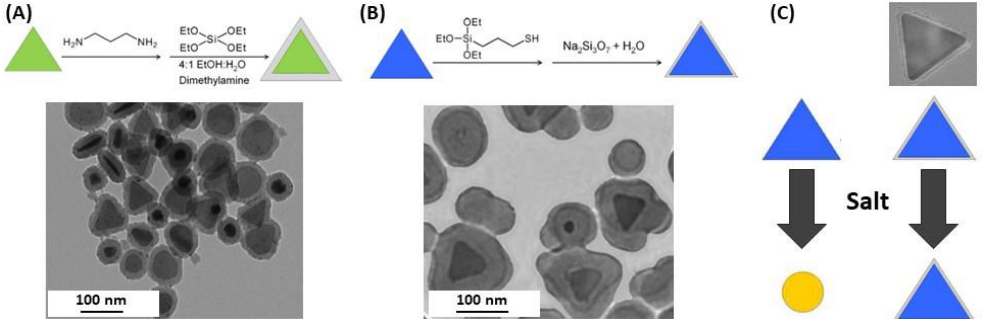
Figure 13. Silica coating of Ag triangular nanoplates by ( A ) diaminopropane priming and ( B ) (3-Mercaptopropyl)triethoxysilane (MPTES) priming followed by deposition from Na 2 Si 3 O 7 solution. ( C ) The silica shell using MPTES on triangular nanoplates (AgTNPls) allows withstanding salts without adversely affecting refractive index (RI) sensitivity in relation to original uncoated particles. Adapted from [113]. Copyright (2013), Elsevier Inc. All rights reserved.